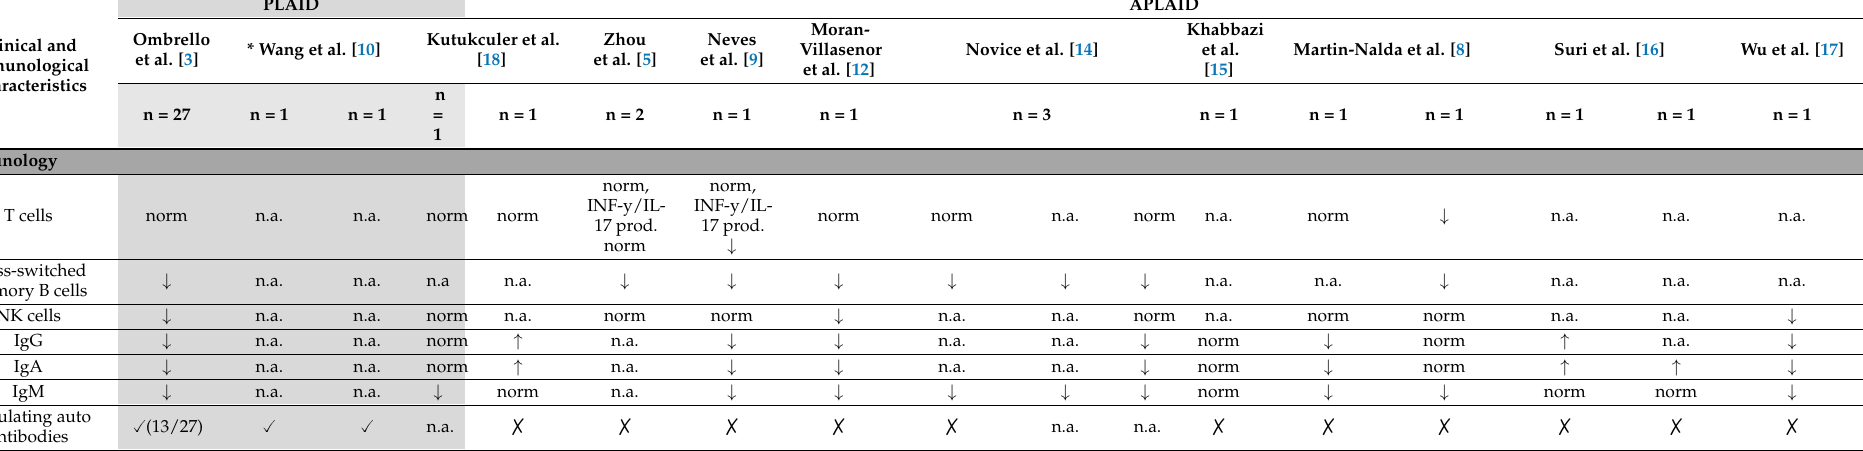
Table 1. Clinical and laboratory characteristics of patients with the heterozygous missense PLCG2 variant (c.77C>T, p.Thr26Met).